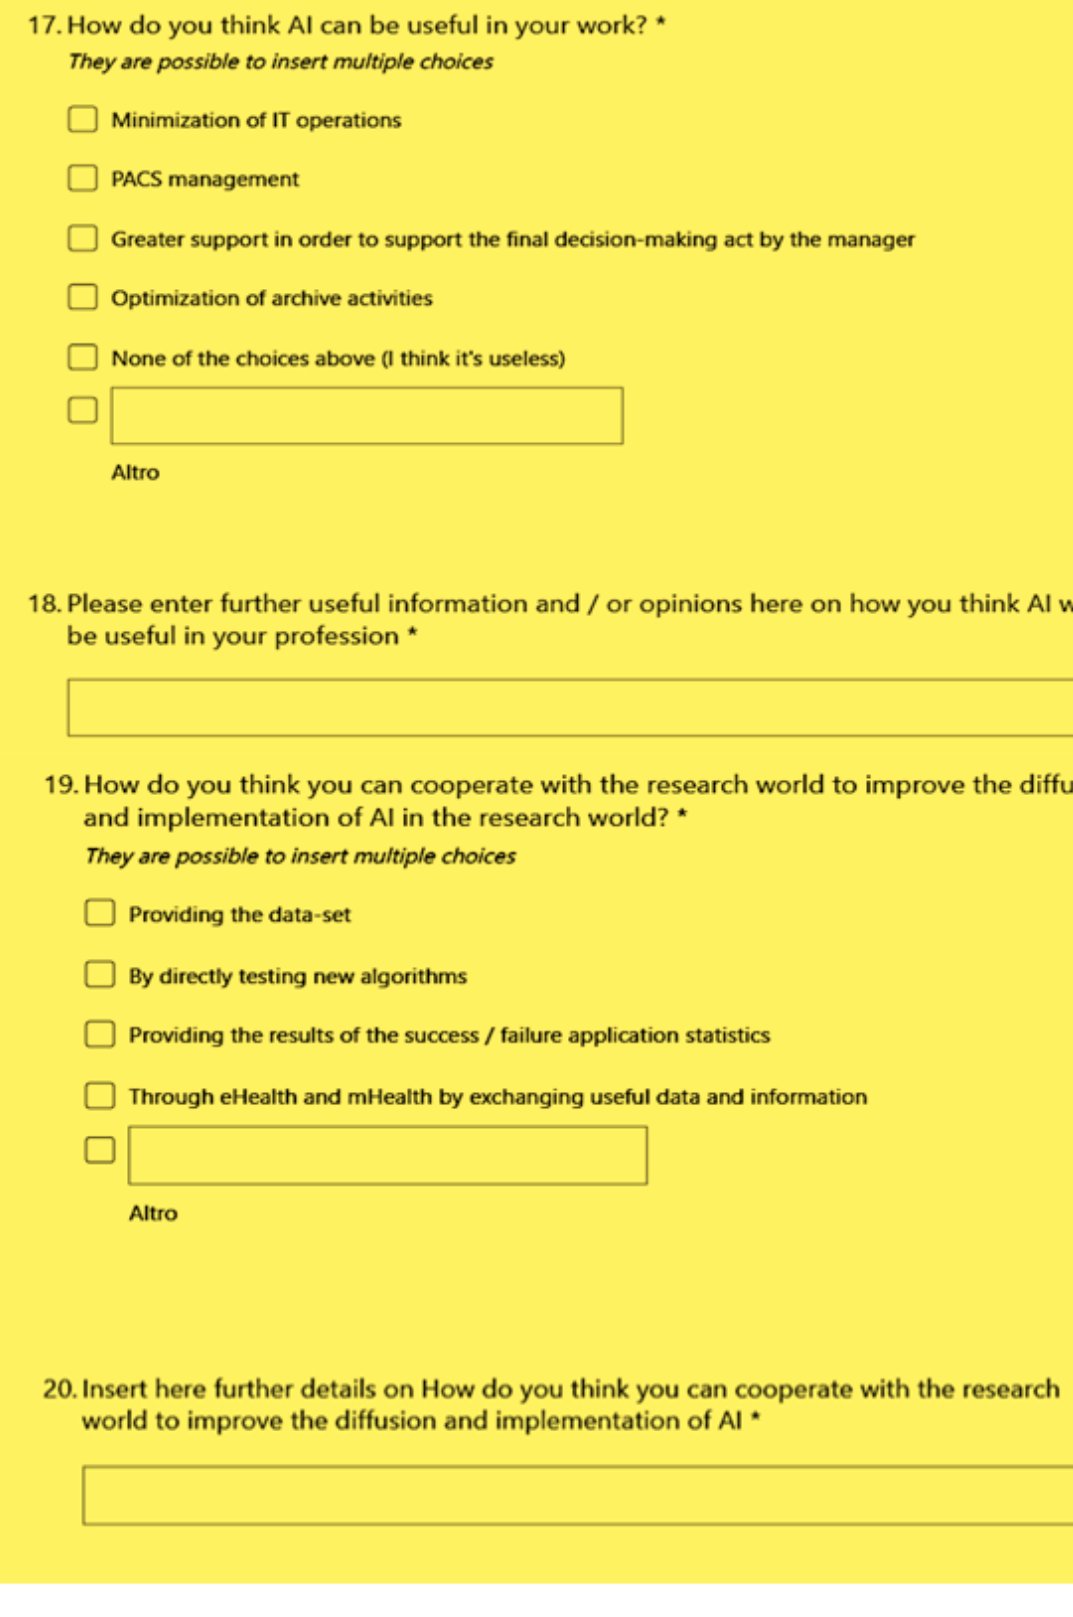
Figure 7. Some sections inserted in the specialized tool for the MRTs focused on the usefulness of AI in the MRT profession and the idea of cooperation of MRTs with the world of research in the field of AI.